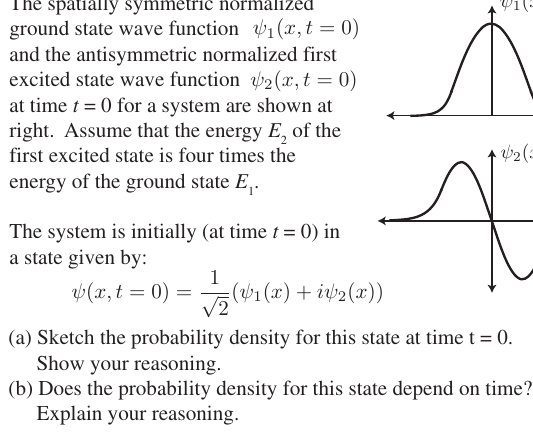
FIG. 4. The post-test question used as part of the end-of-course